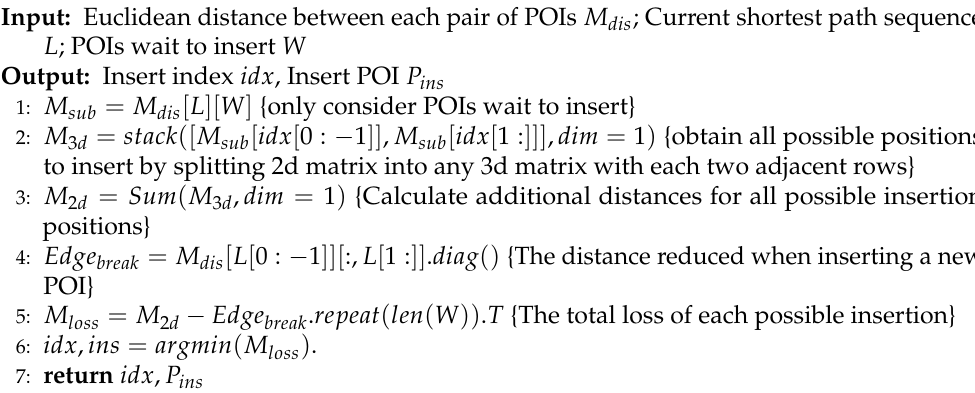
Algorithm 2 Query POI